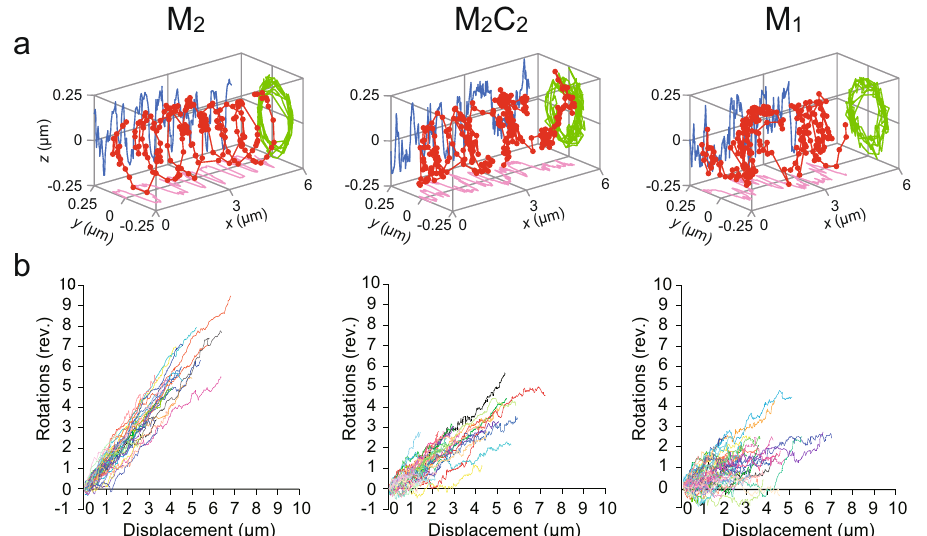
Fig. 2 3D trajectories of MKLP1 kinesin-6 along the suspended microtubule. a 3D traces (red) of M 2 - (left), M 2 C 2 - (middle) and M 1 - (right) coated beads along a suspended microtubule. The traces exhibited left-handed helical motion along the microtubule. The beads coated with multiple M 2 C 2 and M 1 occasionally reversed their rotational direction for a short period of time. X – y (pink), x – z (blue), and y – z (green) traces are shown. b Cumulative revolutions plotted versus the longitudinal displacement for M 2 (left), M 2 C 2 (middle) and M 1 (right). Rotation to the left with respect to the movement in the longitudinal direction is expressed with a positive number. Individual traces were fi tted with linear functions to obtain the inverse pitch. The average inverse pitch (M 2 : 1.3 ± 0.2 µ m − 1 for 36 beads, M 2 C 2 : 0.7 ± 0.4 µ m − 1 for 47 beads, M 1 : 0.5 ± 0.4 µ m − 1 for 47 beads (mean ± SD)) corresponds to the rotational pitch (M 2 : 0.8 ± 0.1 µ m, M 2 C 2 : 1.5 ± 0.8 µ m, M 1 : 2.1 ± 1.6 µ m (mean ± SD)). The beads coated with multiple M 2 C 2 or M 1 more frequently exhibited longer pitches than the beads coated with M 2 due to occasional reversal of the rotational direction.